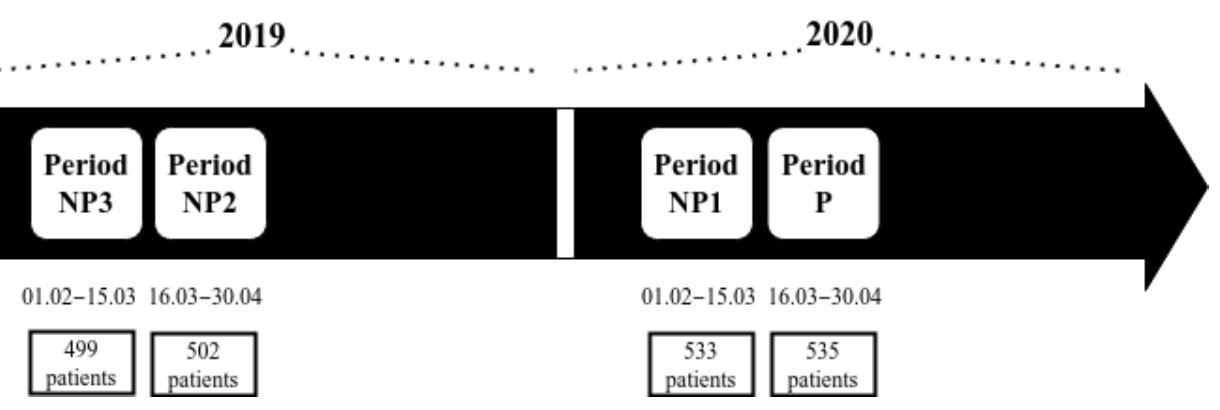
Figure 1. Flowchart of the study periods.